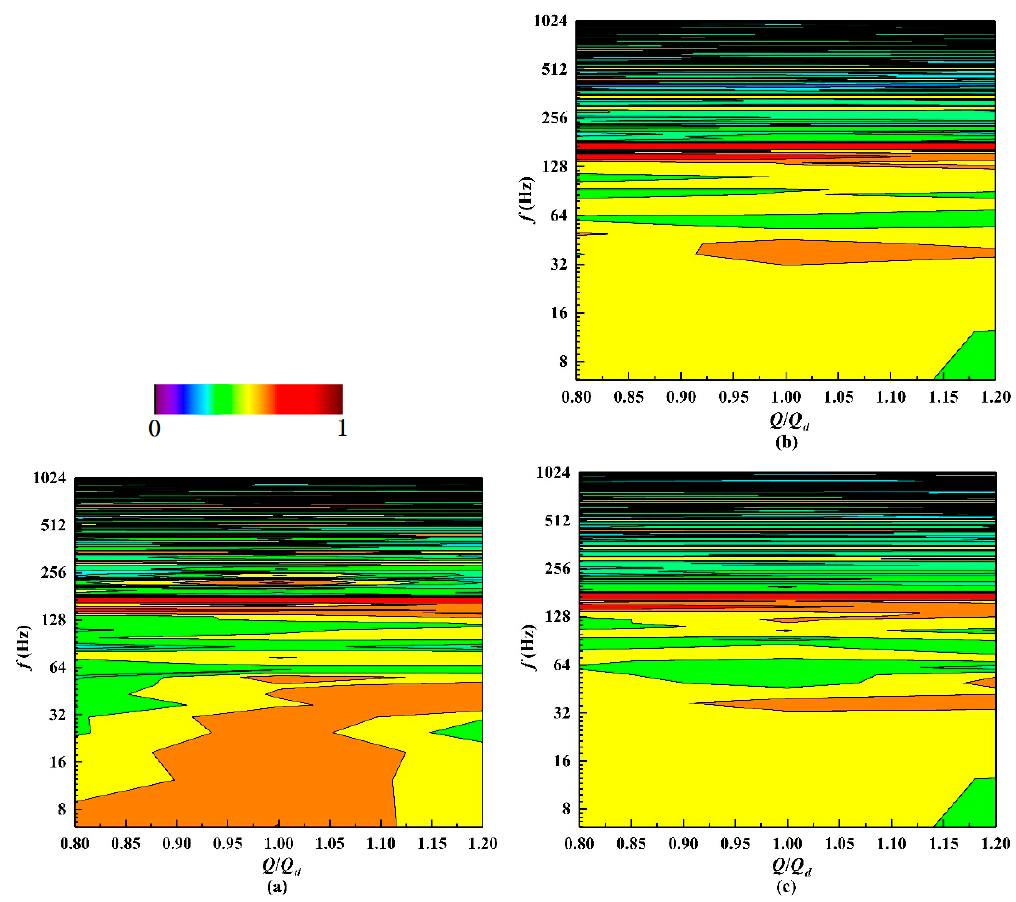
Figure 19. Contour of noise band for ( a ) the standard k- ε , ( b ) the RNG k- ε , and ( c ) the SST k- ω